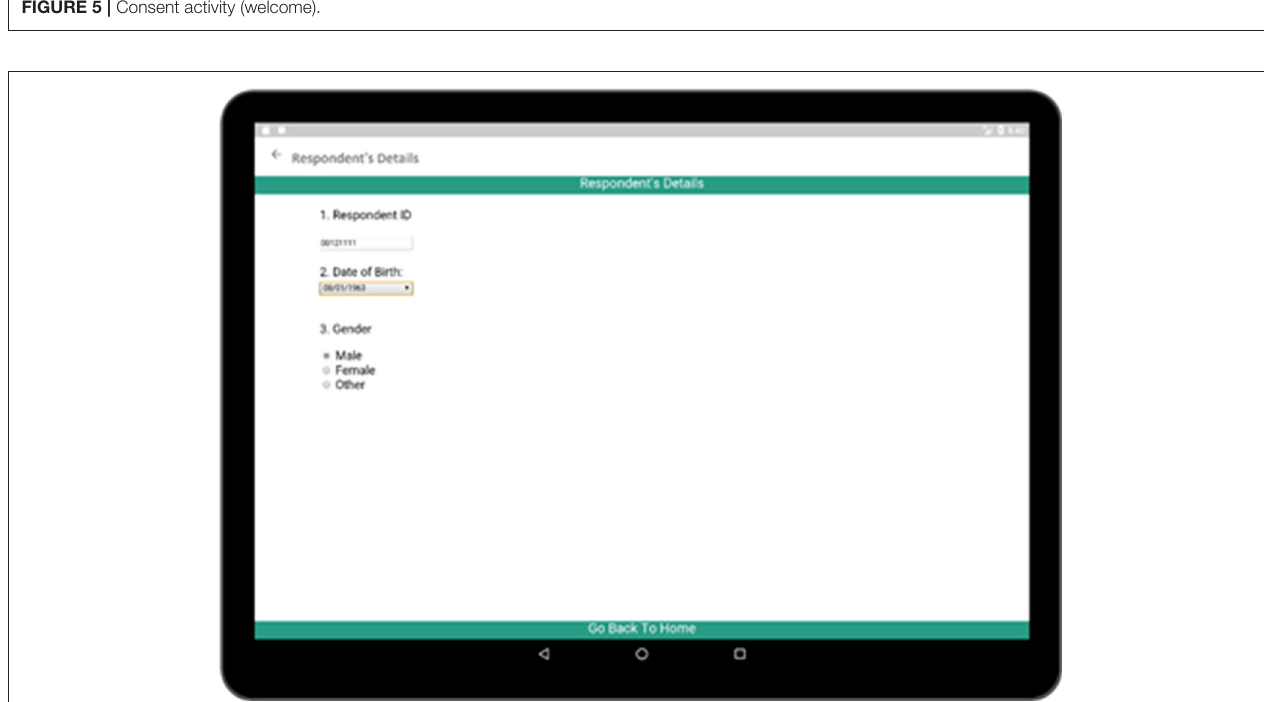
FIGURE 5 | Consent activity